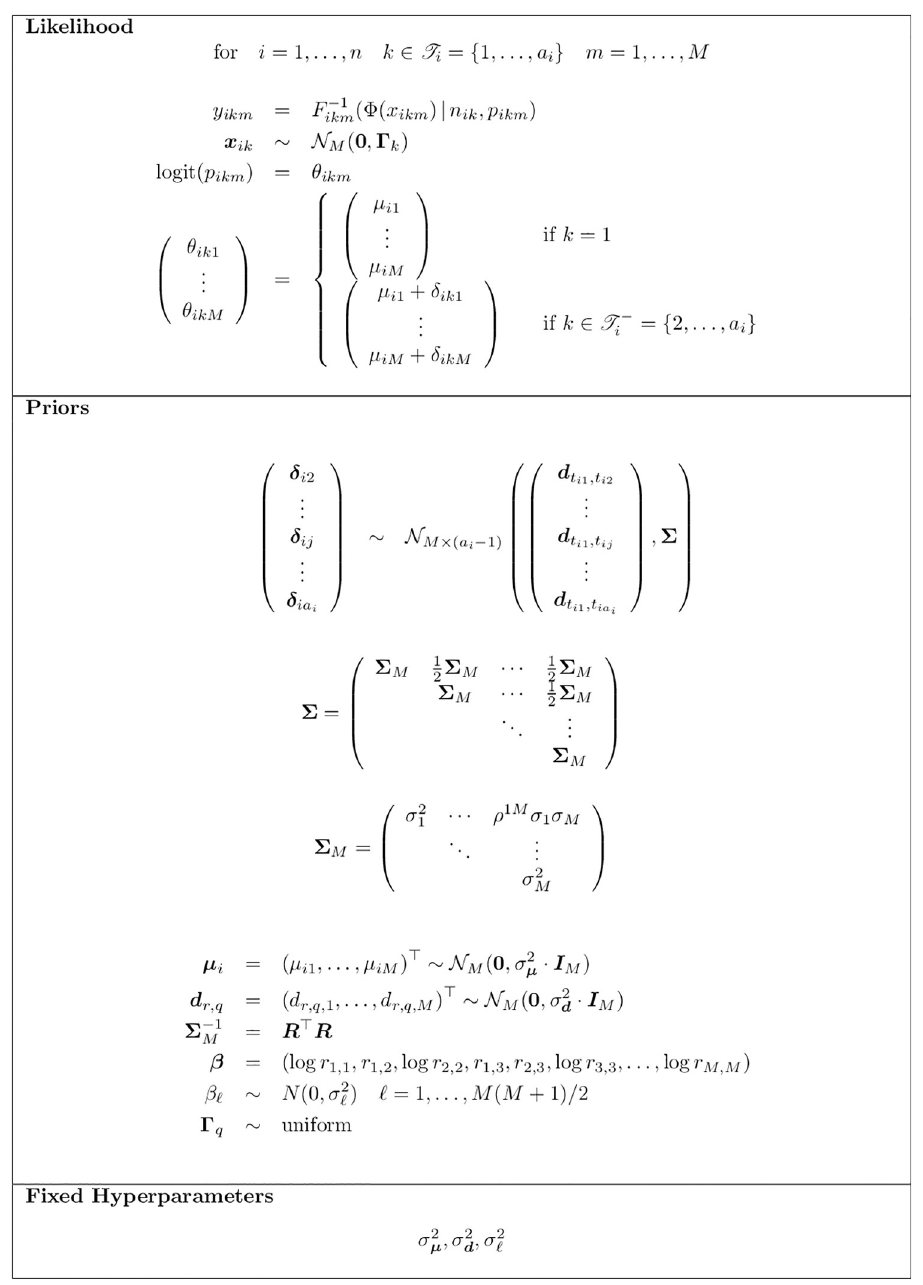
Fig 1. The multiple outcomes network meta-analysis model. The Figure depicts the elements of the suggested hierachical model.